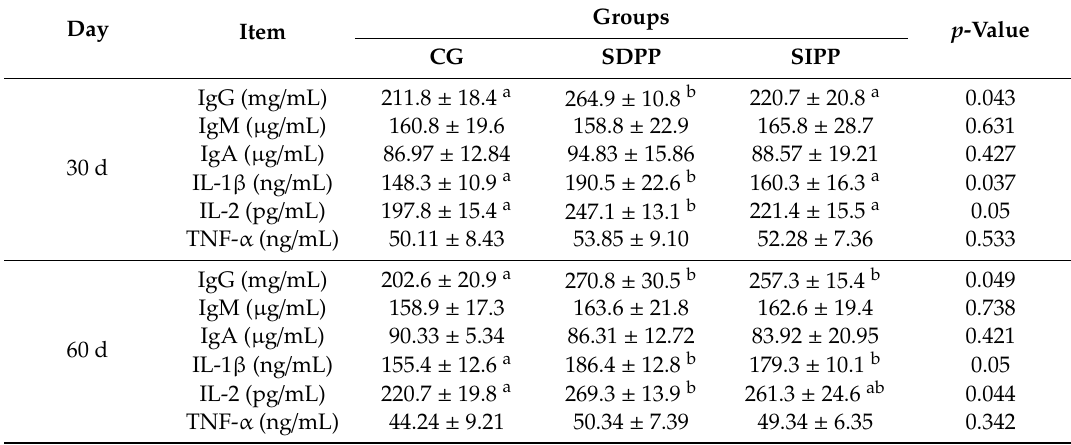
Table 2. E ff ects of photoperiod change on immune system